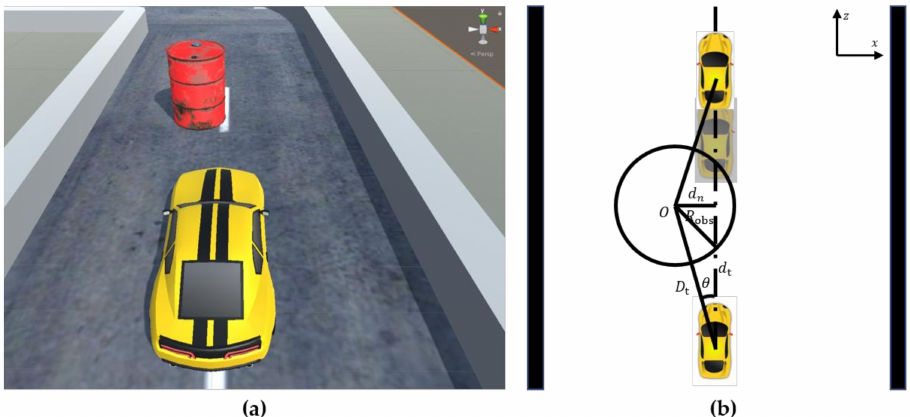
Figure 9. When the direction of the vehicle speed, the position of the obstacle and the center line of the lane are not collinear. ( a ) is the actual vehicle when the obstacle is not on the central axis of the road, ( b ) is the geometrical schematic diagram of the left